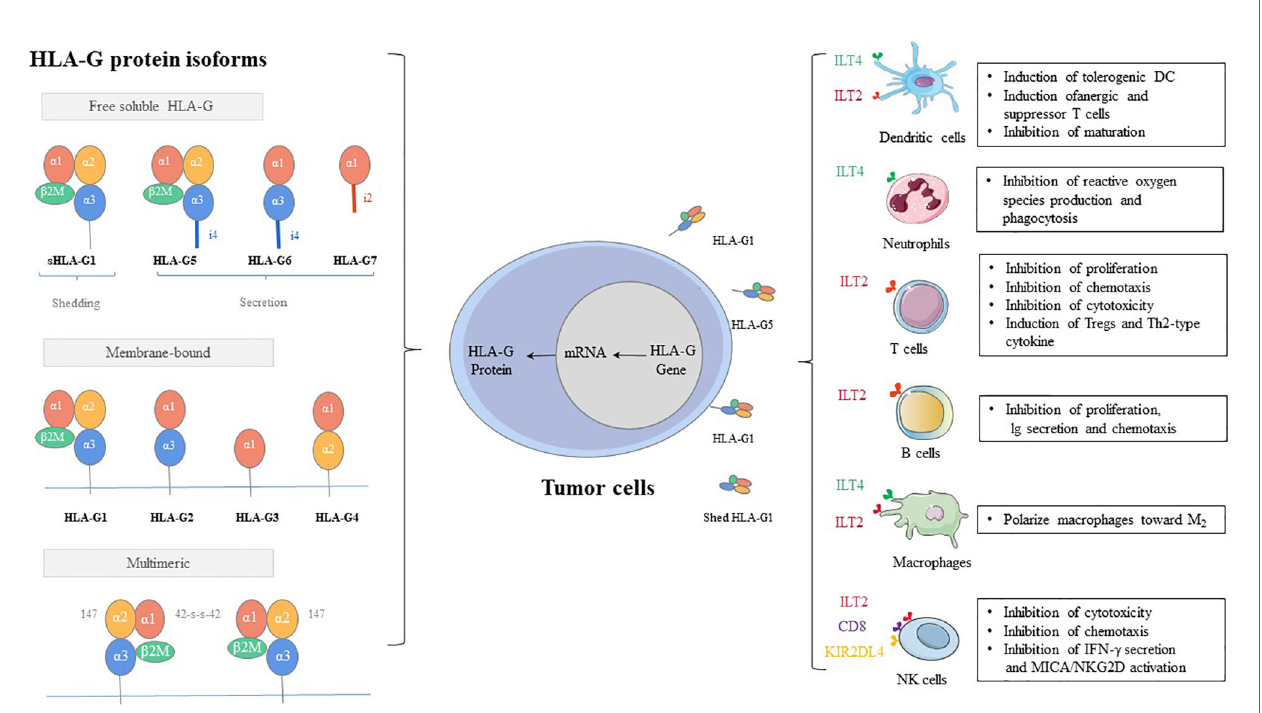
FIGURE 1 | HLA-G protein isoforms and immune-inhibitory